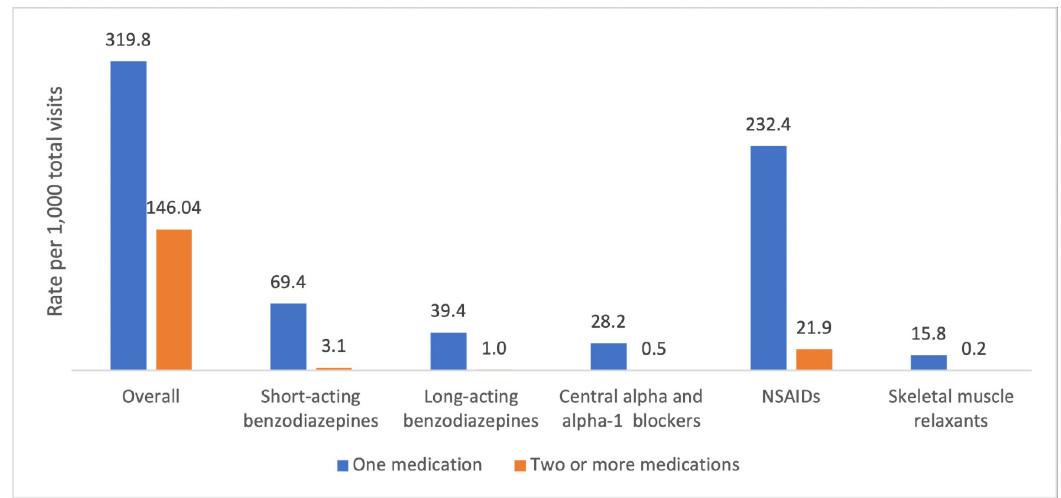
Fig 2. Rate of patients prescribed at least one high-risk medication overall and by medication class. + All comparisons between one medication and two or more medications were deemed statistically significant (p < 0.0001).